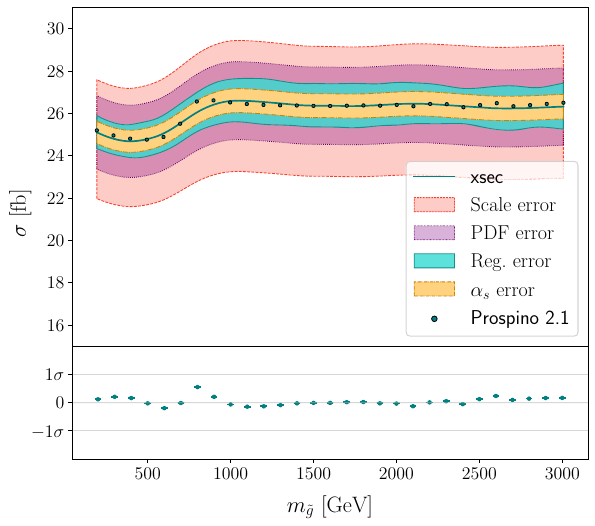
˜ t ˜ t ∗ cross-section on the gluino mass, adopting a stop mass 1 1 = 800GeV, and 1TeV for all other masses. Clearly, of m ˜ t 1